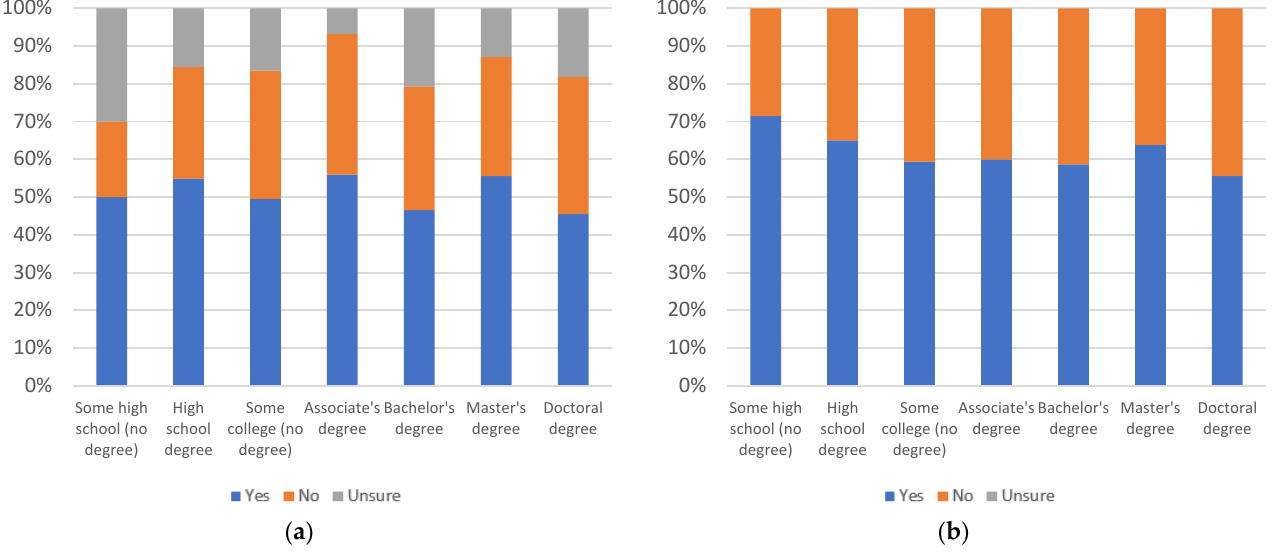
Figure 114. Label trustworthiness judging use, by education level: ( a ) with uncertain respondents (left) and ( b ) without uncertain respondents (right).